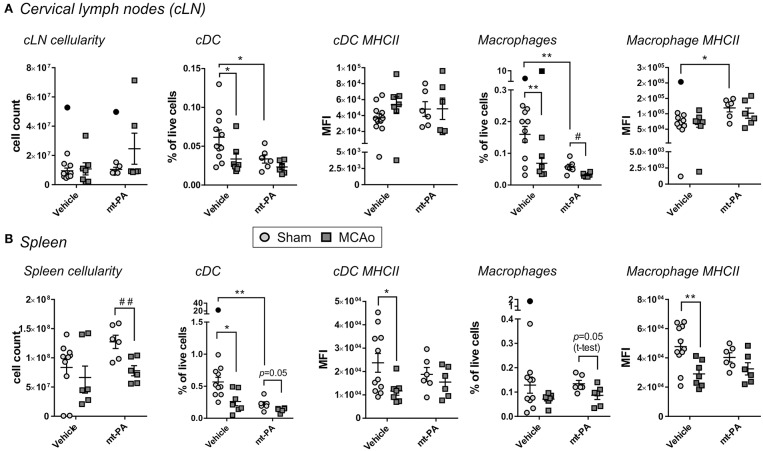
t-PA impacts on professional antigen-presenting cells (APCs) in lymphoid organs. Flow cytometry analysis of total cell count (cellularity; left panels), conventional dendritic cells (cDC) proportions (2nd left panels) and major histocompatibility complex class II (MHC II) expression (middle panels) as well as macrophage proportions (2nd right panels) and MHCII expression (right panels) in cervical lymph nodes (cLN; A) and spleen (B) 23 h after administration of HEPES vehicle or mouse t-PA (mt-PA; 0.9 mg/kg) to C57Bl/6 mice undergoing sham surgery or transient MCAo (1 h). In the cLN (A), t-PA supresses cDC and macrophage numbers in sham-operated mice, but increases macrophage MHC II expression (A). Similar, t-PA-mediated reduction in cDCs is observed in the spleen (B), without effect on macrophage numbers (B). Notably, significant stroke-induced reductions in MHC II expression seen in splenic cDCs and macrophages are lost with t-PA treatment, potentially due to overall suppression of MHC II also in sham-treated animals. Taken together, t-PA affects key APCs in lymphoid organs irrespective of stroke, an effect which could impact the immune response also after thrombolysis. Data is shown as individual animals with mean ± SEM. n = 10–11 for sham vehicle, 6 for sham mt-PA, 7 for MCAo vehicle, 6 for MCAo mt-PA. *p < 0.05, **p< 0.01 by two-ANOVA with Sidak's post-hoc, #p < 0.05, ##p < 0.01 by student t-test. Outliers are denoted in black symbols and excluded from the analysis.